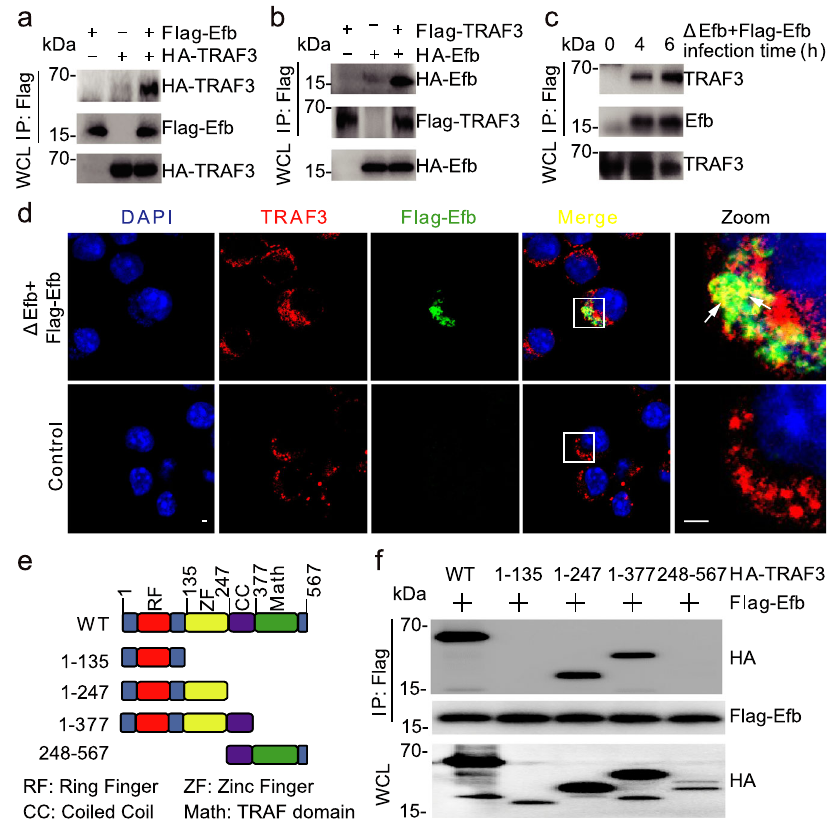
Fig.2|EfbinteractswithTRAF3.a , b Immunoblotsofwholecelllysates(WCL)and immunoprecipitation (IP) products of WCL from HEK293T cells transfected with indicated plasmids. c Immunoblots of WCL and IP products of WCL from MH-S infected with Δ Efb+Flag − Efb for indicated times (MOI=25). d Immuno fl uorescence assay of MH-S infected with Δ Efb+Flag − Efb for 4h